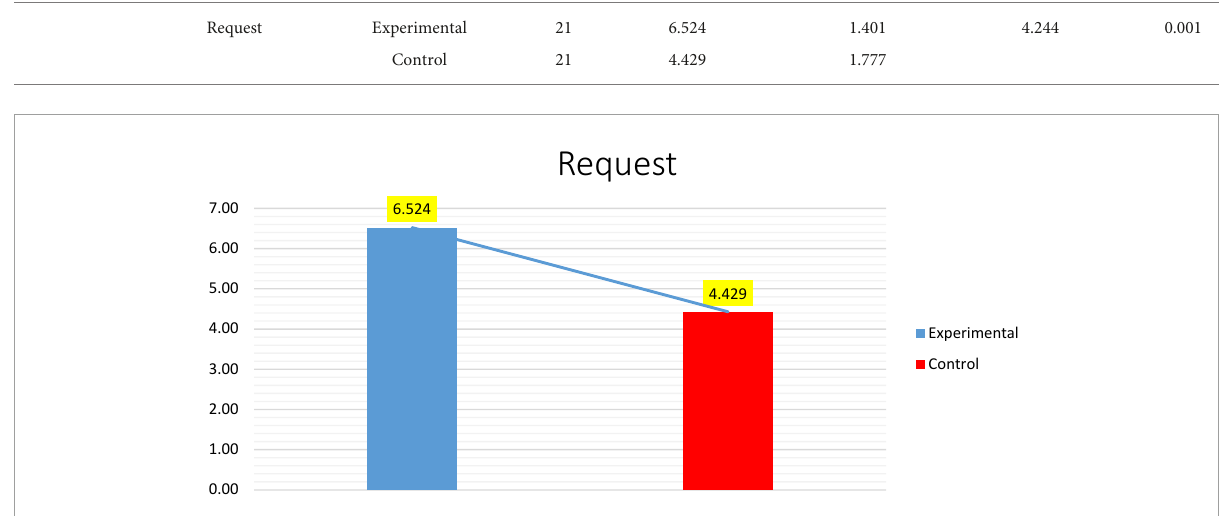
TABLE 3 Independent sample t -test between the experimental and control group for post-test (Request). Post-test